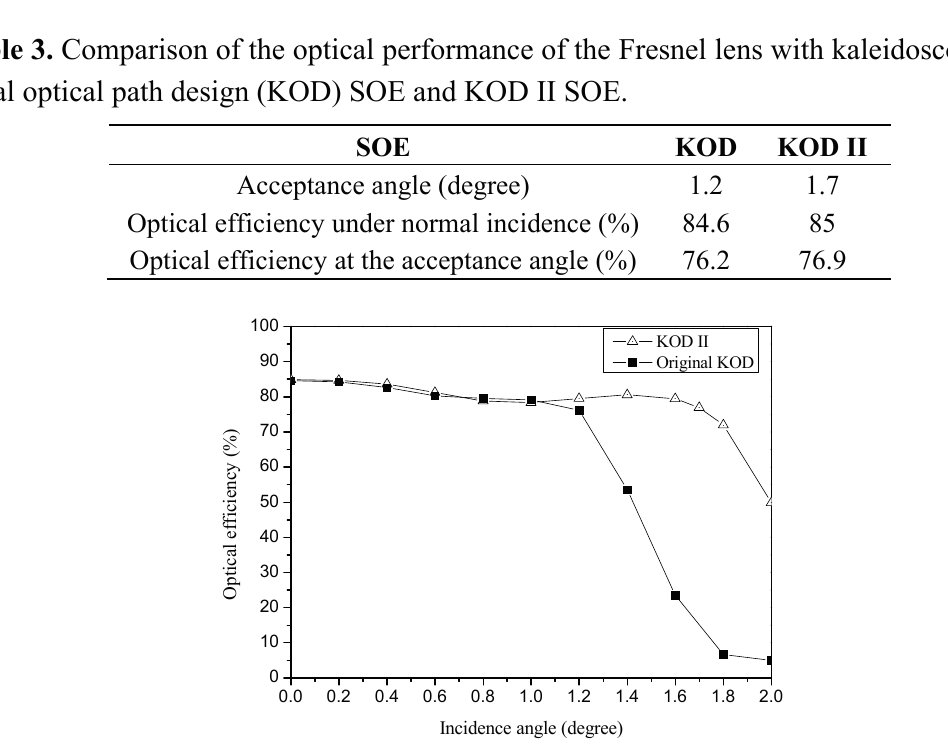
Figure 13. Optical efficiency of the Fresnel lens with KOD SOE and KOD II